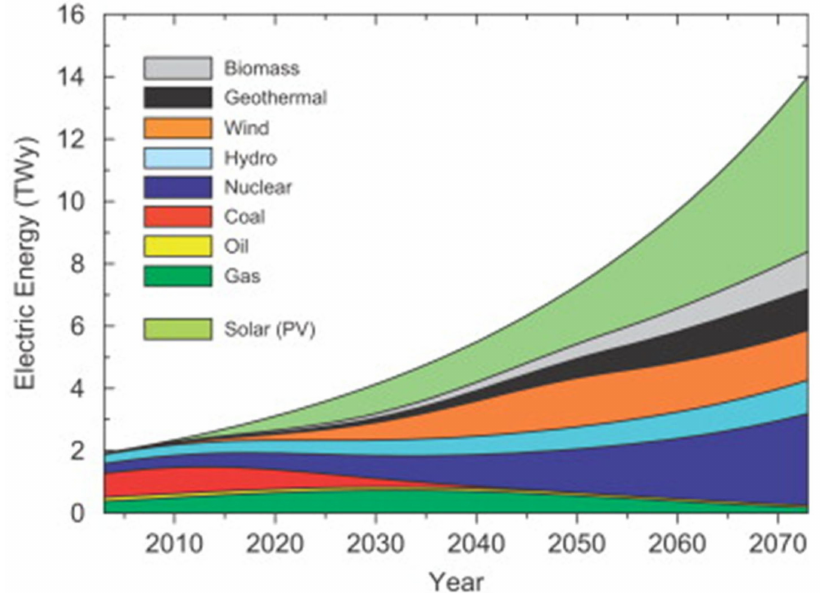
Figure 1. Presents electrical energy production for the next 6 decades (with consideration that the emission of CO 2 will be held under 450 ppmv). Re-used with permission [5], Copyright © 2008